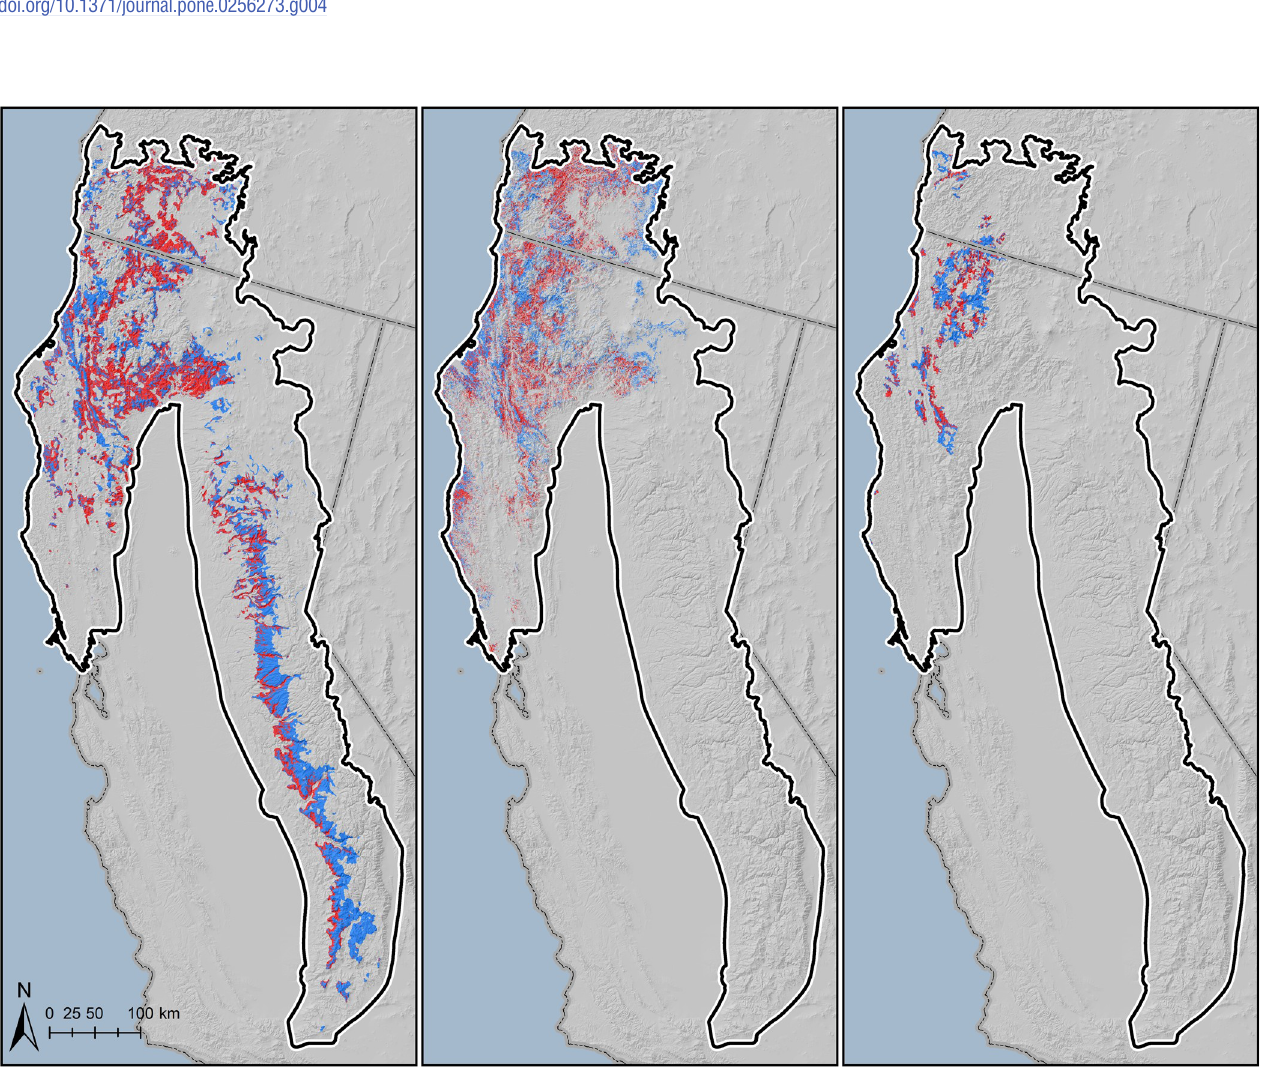
Fig 5. Overlap of moderate to high trespass cannabis cultivation site likelihood (red) with modeled habitat for Pacific fisher (left), northern spotted owl (center) and Humboldt marten (right).